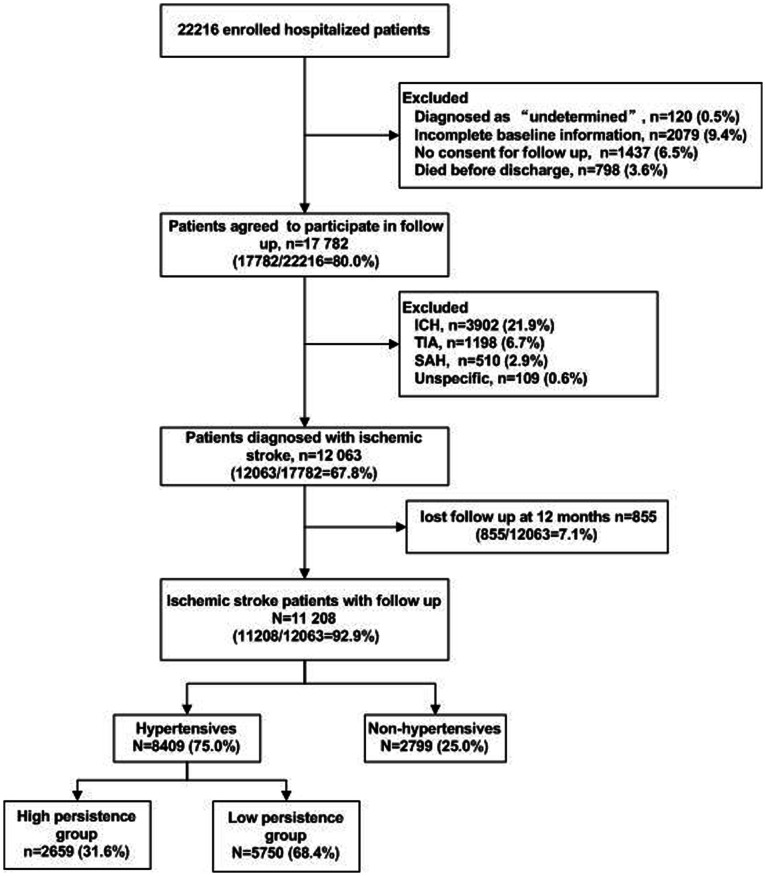
Patient flow diagram.Abbreviations: ICH, Intracerebral Hemorrhage; SAH, Subarachnoid Hemorrhage; TIA, Transient ischemic attack.